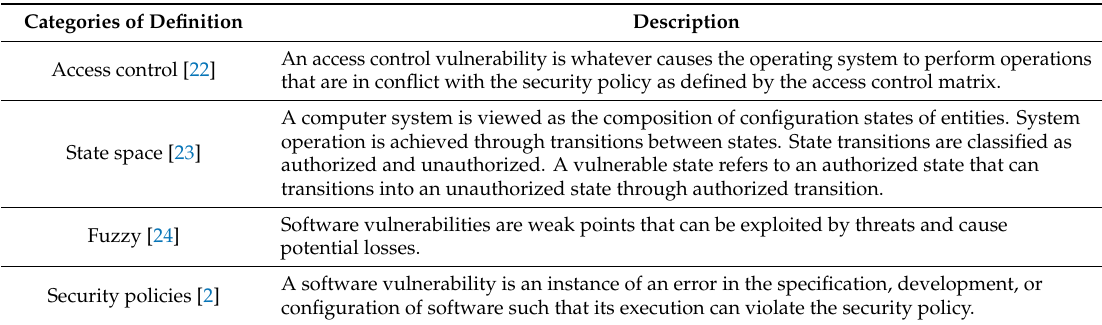
Table 1. Di ff erent categories of definitions on software